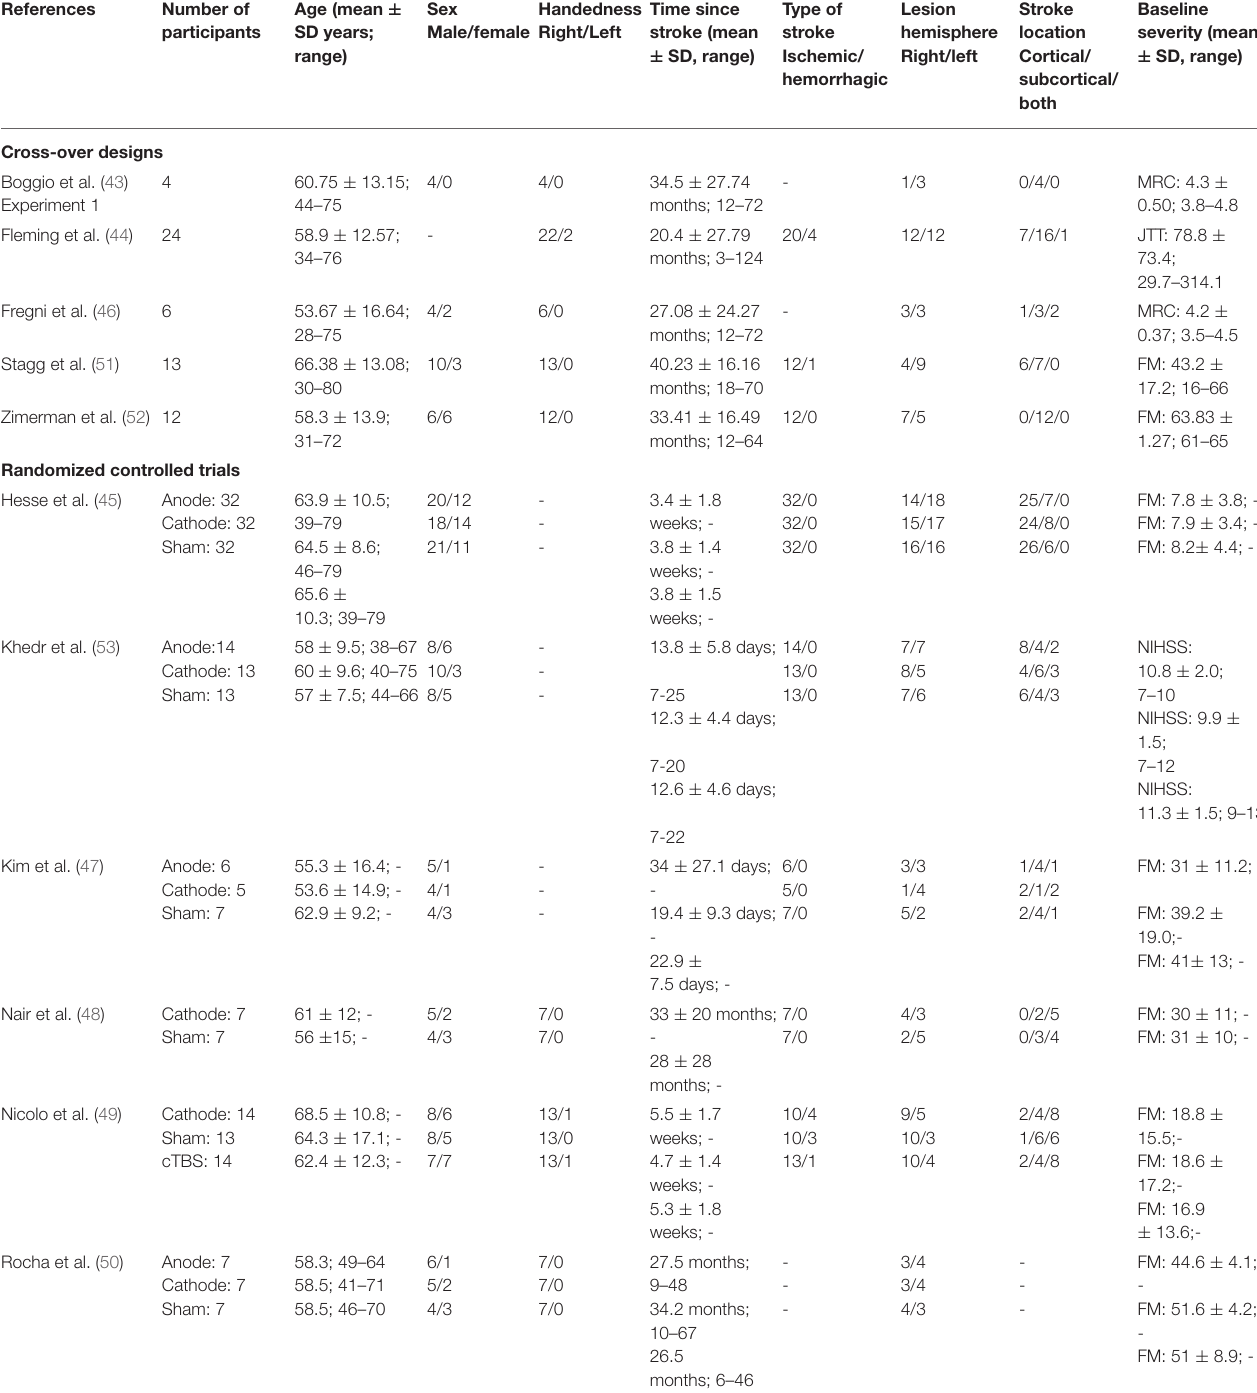
TABLE 3 | Participants’